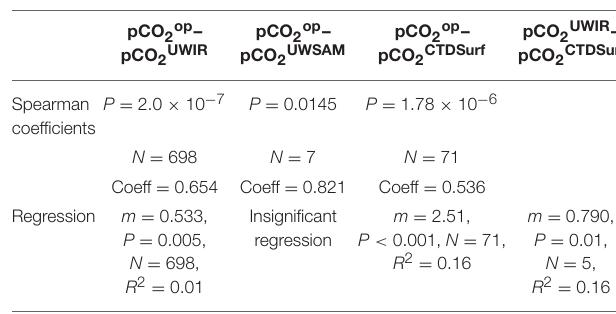
TABLE 2 | Row 1 details the Spearman’s rank correlation coefficients between the different pCO 2 measurements collected on the cruise where P = significance, N = number of samples, Coeff = the